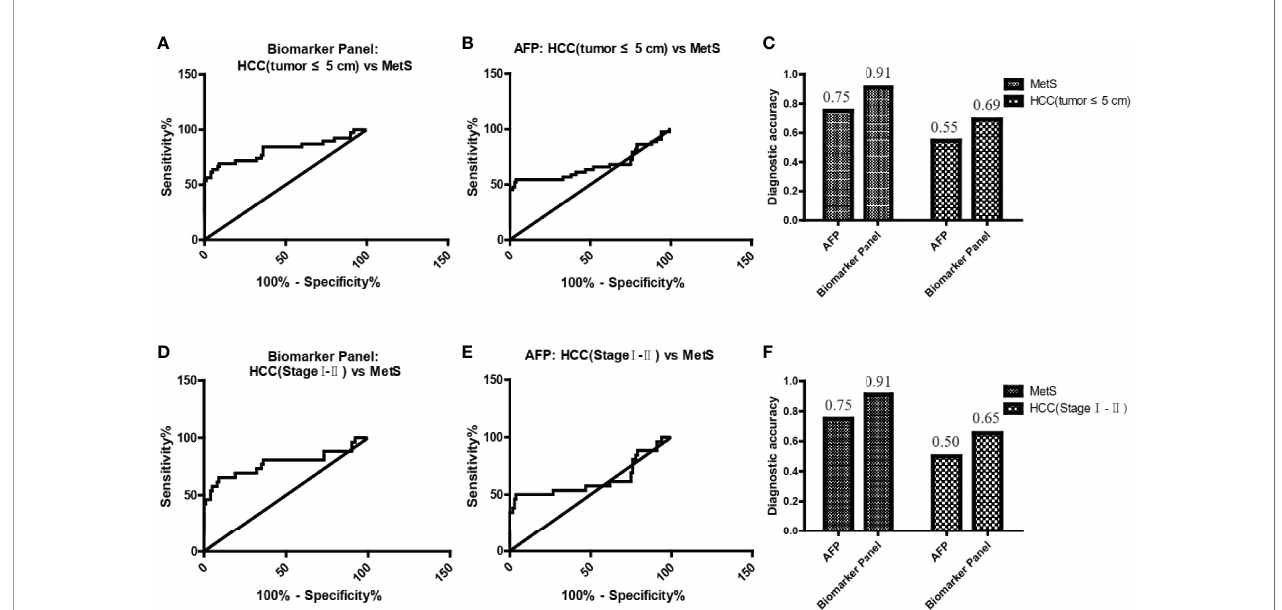
FIGURE 5 | The role of the biomarker panel in the diagnosis of small and early-stage HCC patients. (A) The ROC curve of the biomarker panel for discriminating small (tumor ≤ 5 cm) MetS(+) HCC patients from MetS individuals. (B) The ROC curve of AFP for discriminating small (tumor ≤ 5 cm) MetS(+) HCC patients from MetS individuals. (C) The diagnostic accuracy of AFP and the biomarker panel for the diagnosis of MetS and small (tumor ≤ 5 cm) MetS(+) HCC, respectively. (D) The ROC curve of the biomarker panel for discriminating early-stage (stage I-II) MetS(+) HCC patients from MetS individuals. (E) The ROC curve of AFP for discriminating early-stage (stage I-II) MetS(+) HCC patients from MetS individuals. (F) The diagnostic accuracy of AFP and the biomarker panel for the diagnosis of MetS and early-stage (stage I-II) MetS(+) HCC, respectively. ROC, receiver operating